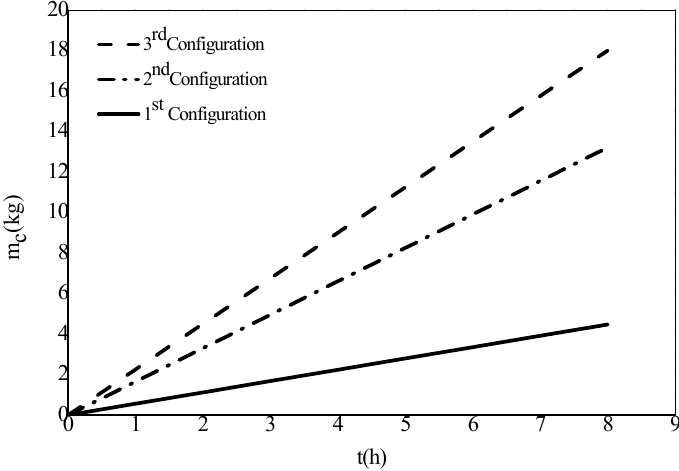
Figure 9. The e ff ect of the di ff erent design configurations on the freshwater Figure 9. The effect of the different design configurations on the freshwater production.